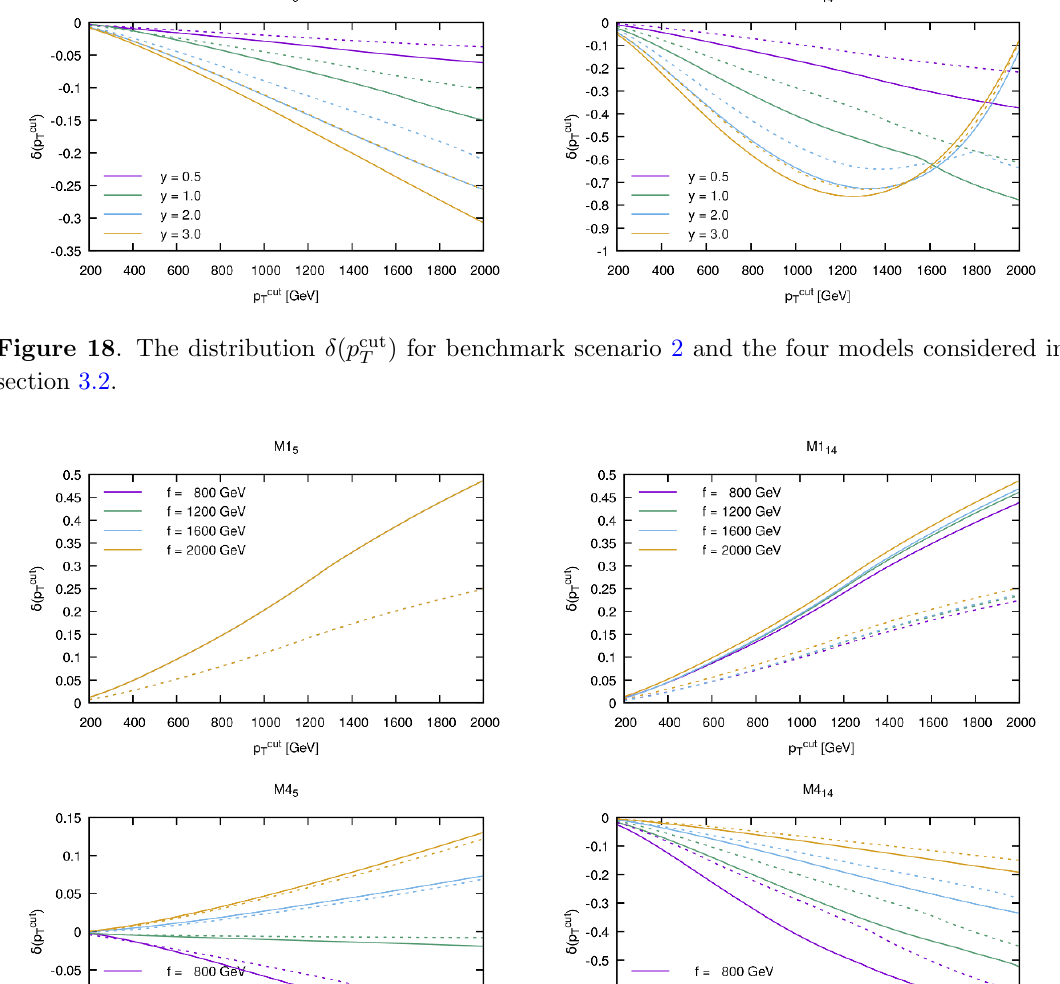
) for benchmark scenario 3 and the four models considered in T